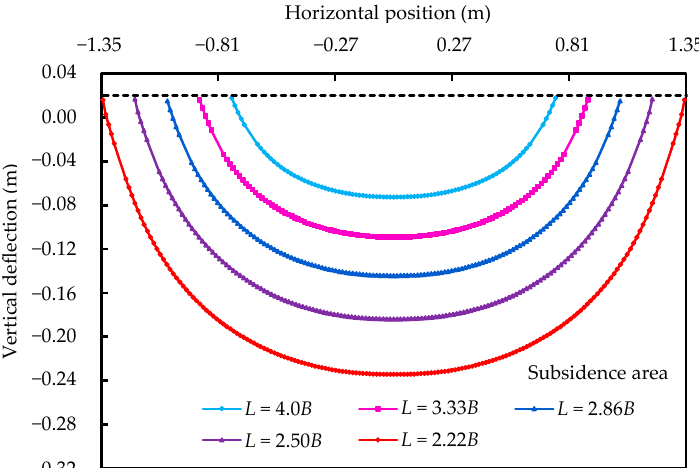
Figure 11. Vertical deflection distribution of the geotextile in the subsidence area for the different subsidence widths.